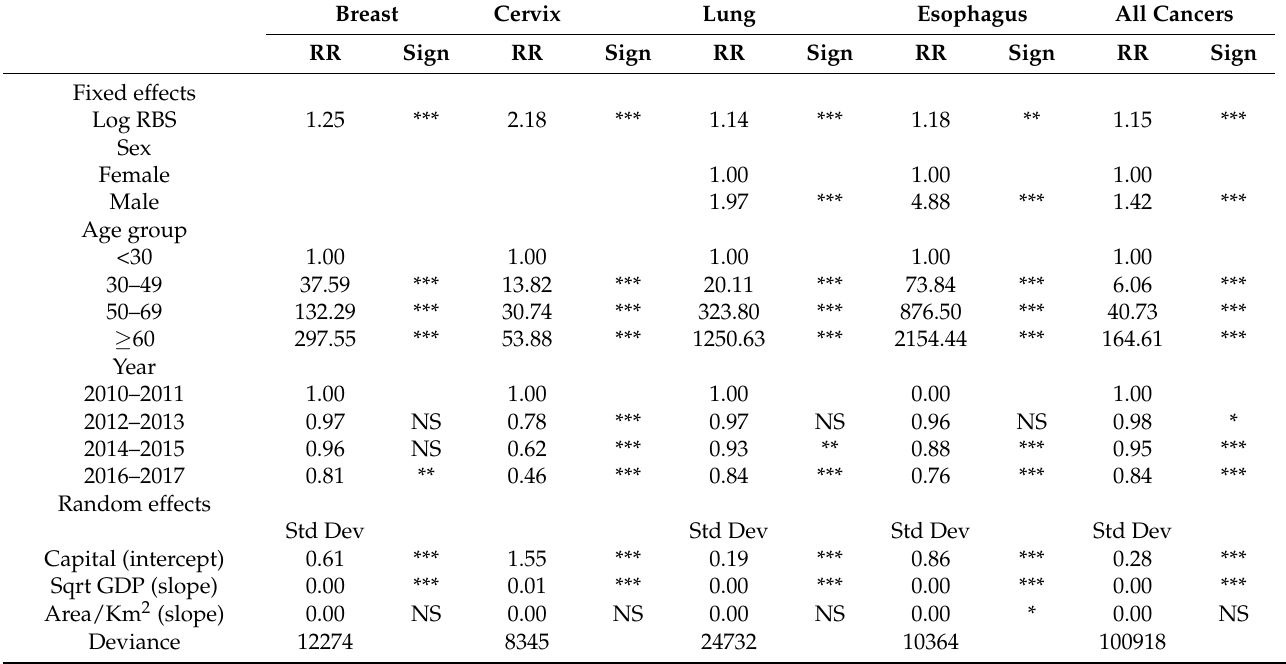
Table 2. Adjusted risk of cancer mortality in Brazilian capitals. Breast Cervix Lung Esophagus All